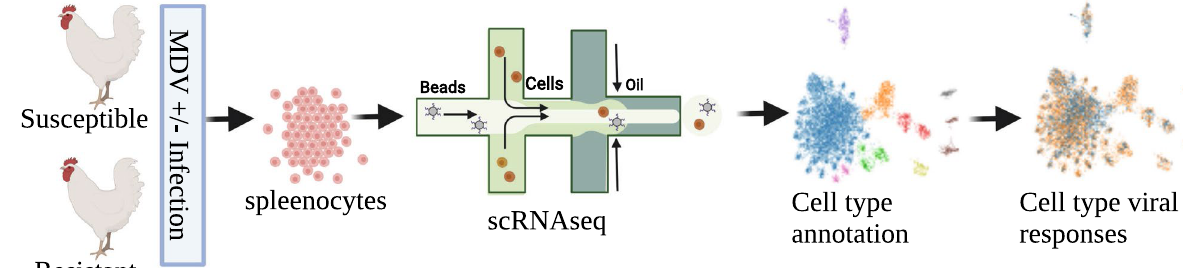
Figure 1. Experimental design to differentiate splenic-derived lymphocyte transcriptome responses to MDV infection in resistant and susceptible lines of